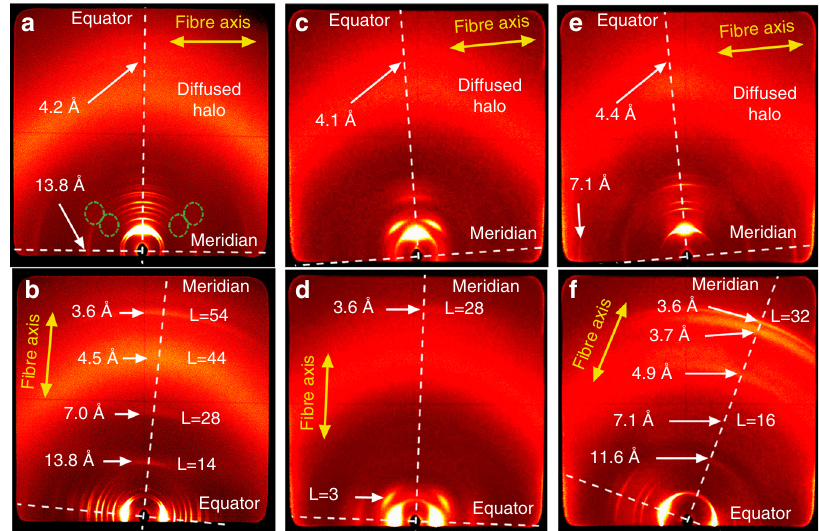
Fig. 3 WAXS patterns of PBIs 2 , 3 , and 4 . WAXS diffraction pattern of aligned fi bers of a , b PBI 2 at 160 °C, c , d PBI 3 at 180 °C, and e , f PBI 4 at 224 °C. The relative position of the fi bers are indicated by yellow arrows and the meridian and equator by white dashed lines. The re fl ections on the equator are indexed according to Col h or Col r phases in Fig. 2. The re fl ections on the meridian that are attributed to layer lines are indicated as L = X. Dashed green lines indicate additional diffuse re fl ections at small